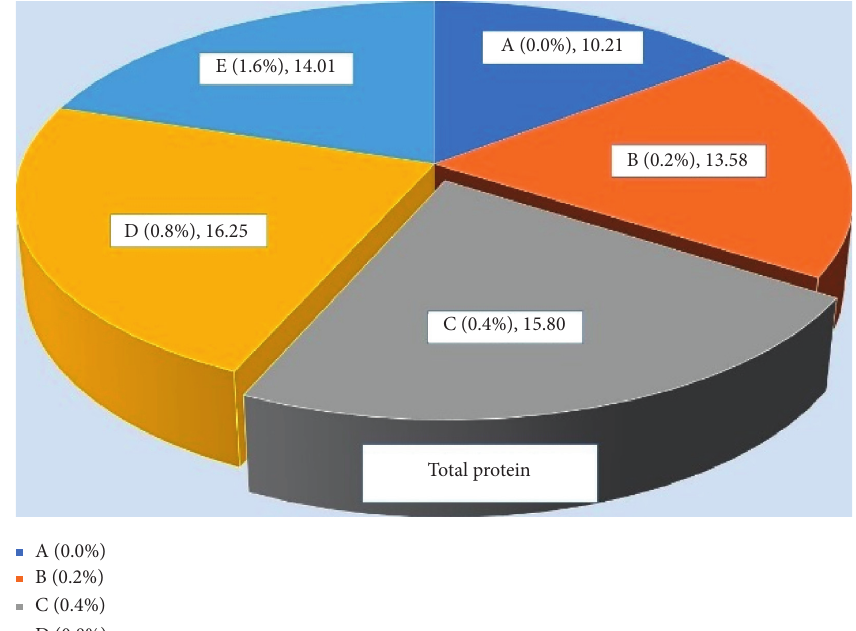
Figure 9: Cyprinus carpio fed varied doses of Aloe vera and total protein (TP) contents from liver tissues were studied after 90 days of feeding